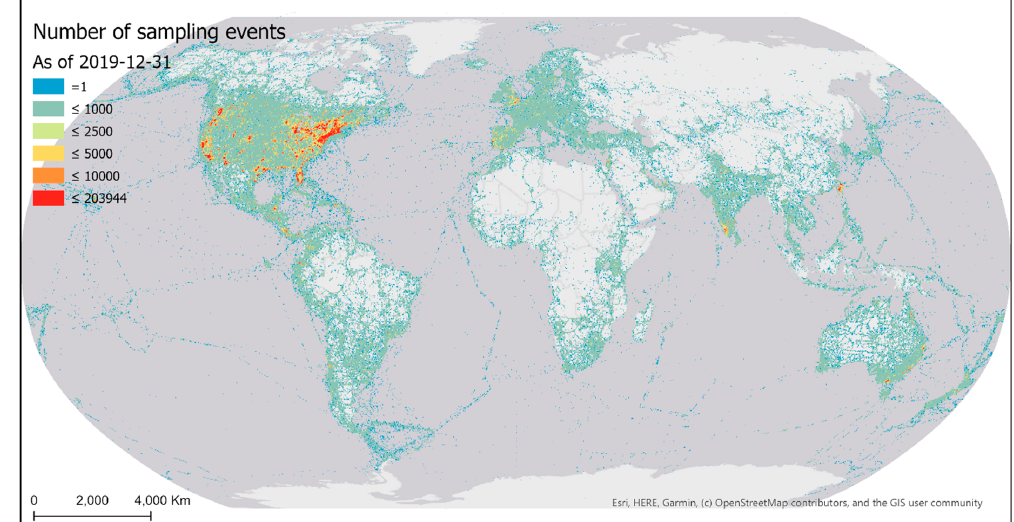
Figure 4. The number of cumulative eBird sampling events as of 31 December 2019 mapped over 0.25° latitude × 0.25° longitude grid cells. Intervals were determined loosely following quartile classification method.